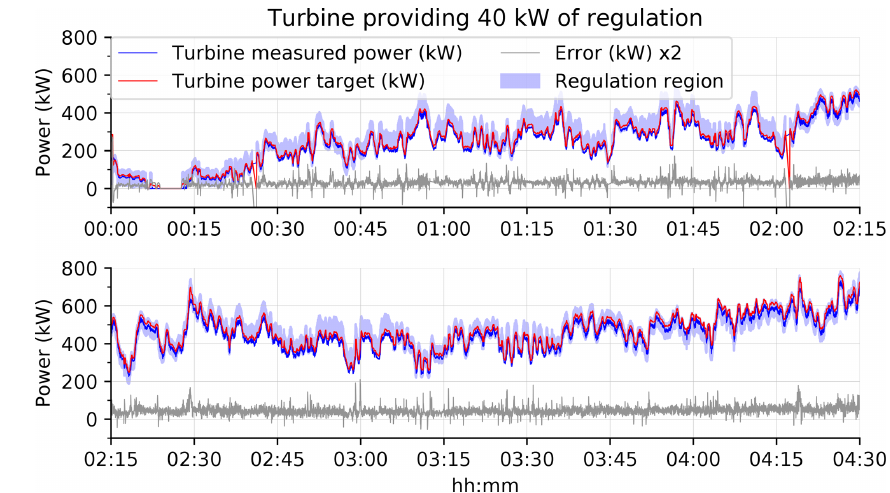
Figure 9. Test 3: providing 40kW of regulation when wind speeds are below rated. Blue shaded region is the range of possible regulation. Note that the error value is multiplied by a factor of 2 for